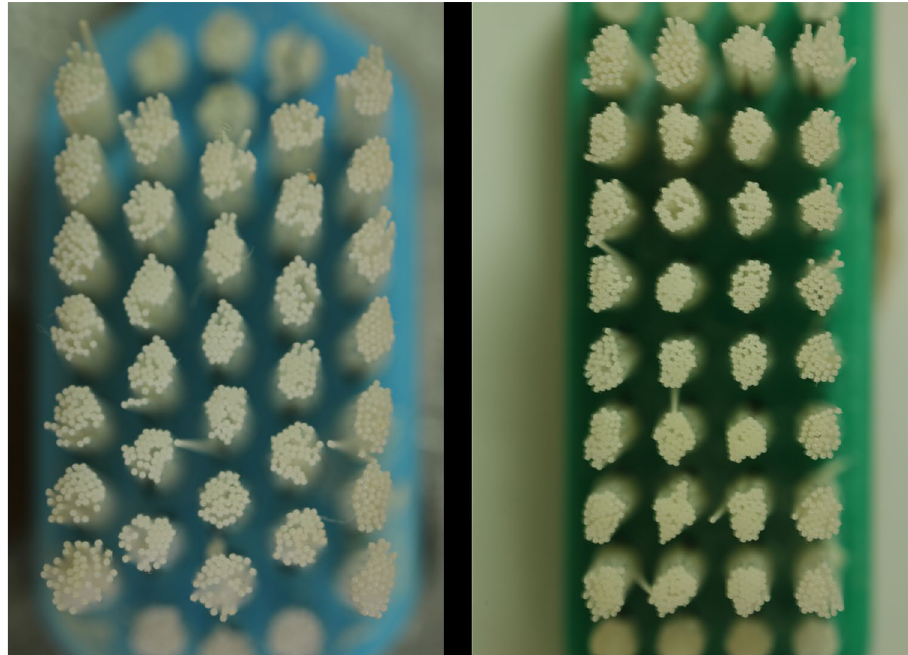
Figure 1. Top view pictures of the crossed tuft (left) and parallel tuft (right) toothbrushes (both medium bristle stiffness. The soft bristle toothbrushes had the same geometric